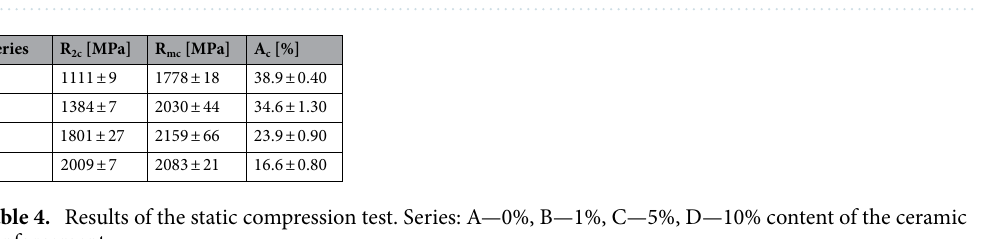
Figure 7. Stress–strain curve of manufactured composites Ti6Al4V/DE from the ( A ) tensile test, ( B ) static compression test. Series: A—0%, B—1%, C—5%, D—10% content of the ceramic reinforcement.